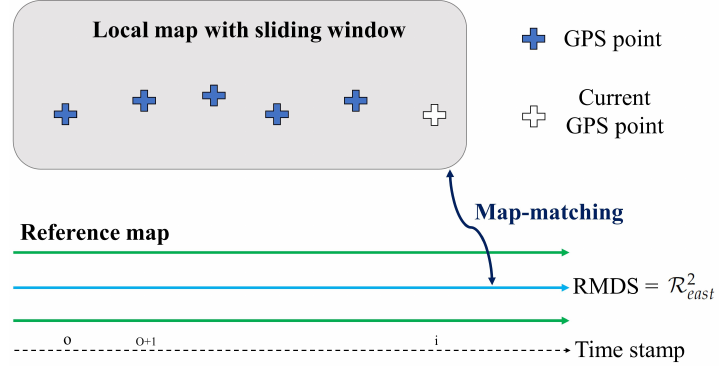
Figure 7. Composition of maps for map